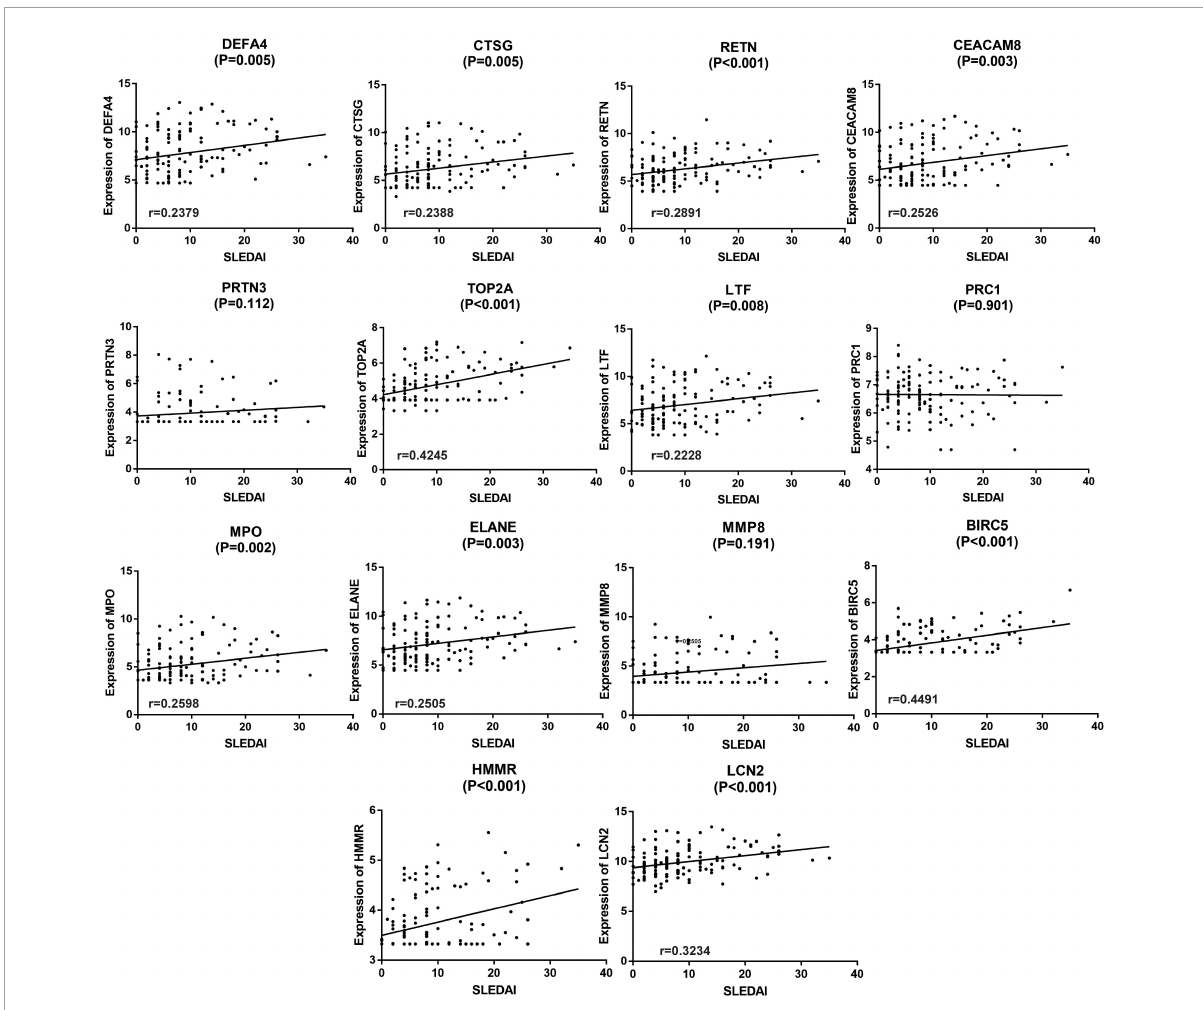
FIGURE7 Linear correlation analysis of the 14 hub genes and SLEDAI. The expression of 10 hub genes (except PRTN3, PRC1, MMP8, and HMMR) were discovered to be linear related to SLEDAI and validated by GSE65391. P < 0.05 was considered statistically significant.